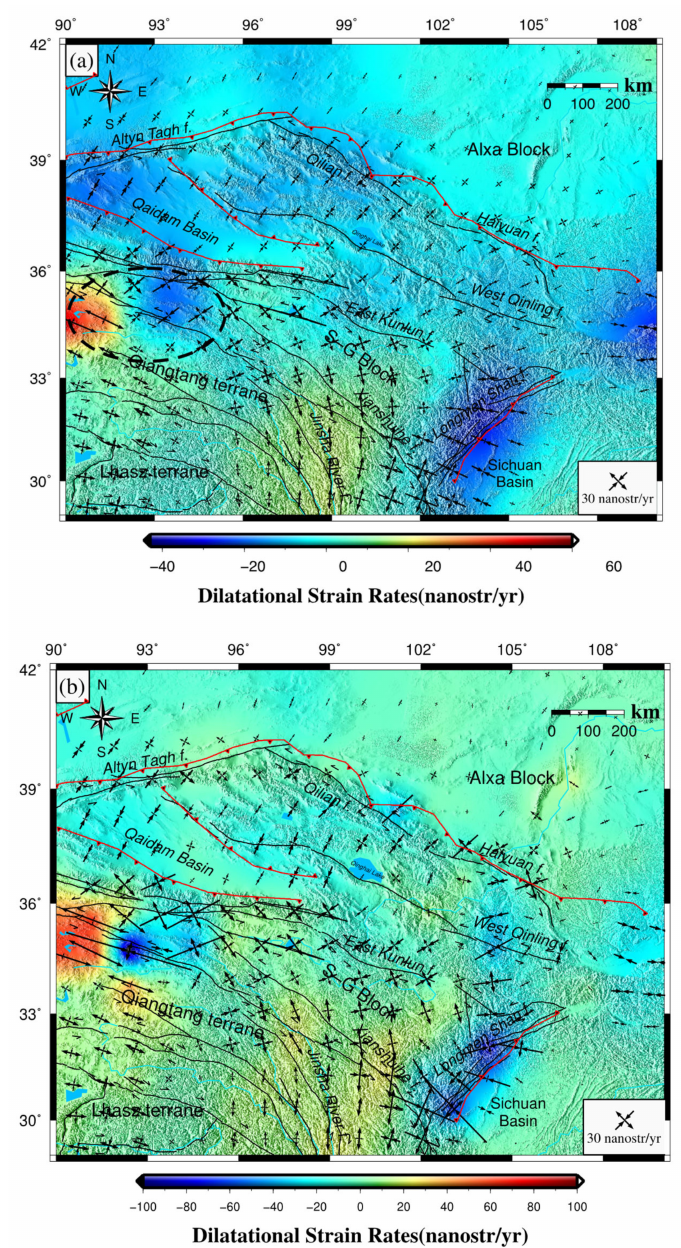
Figure 9. GPS-derived rates of principal strain (arrow pairs) and dilatational rate of strain as continu- ous background color patterns using ( a ) the grid-distance weighted routine with α = 100 km, and ( b ) the grid-nearest neighbor routine with 12 neighbors and a maximum radius = 300 km, respectively. The color bars are different in each sub-figure to identify regional strain patterns. The red-dashed ellipse in sub-figure ( a ) represents the area with abnormal dilatational